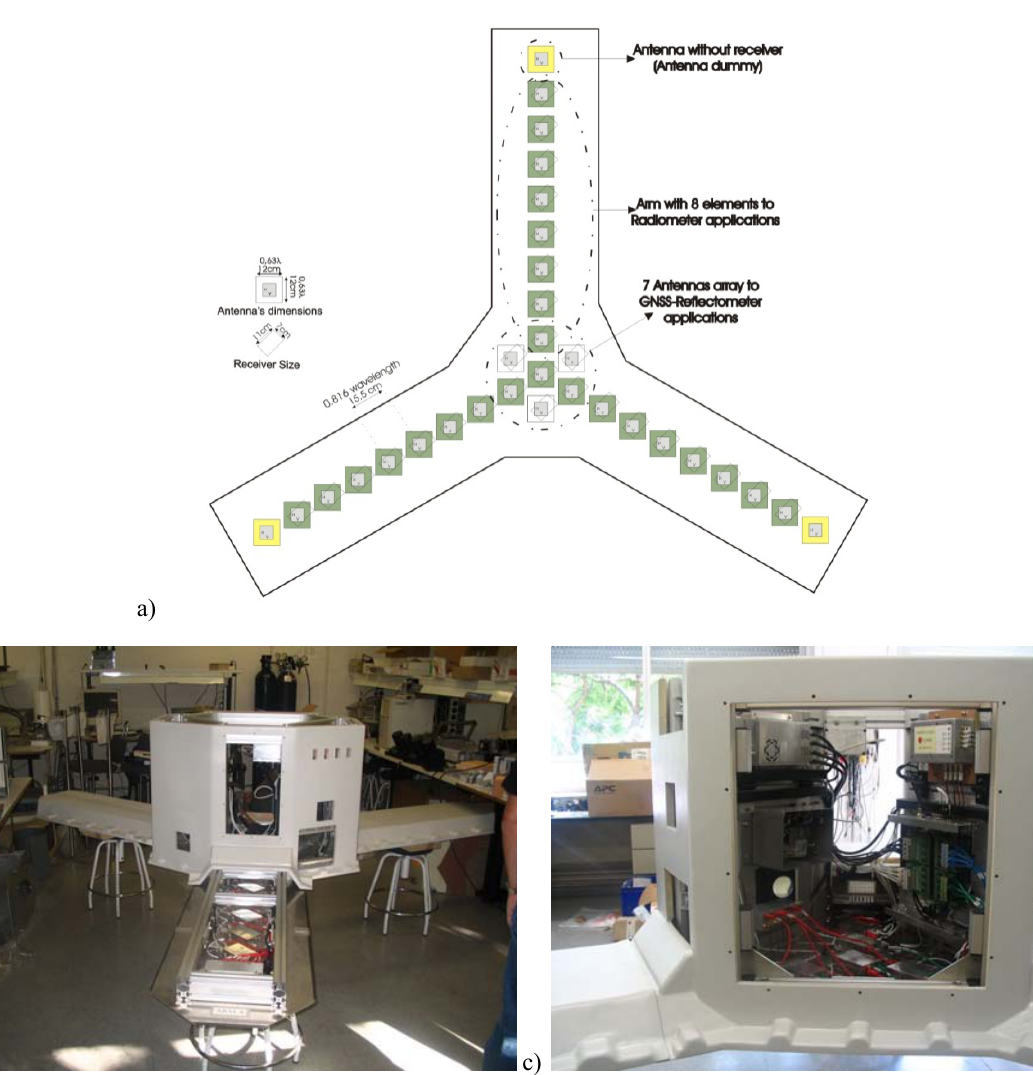
supply (left-hand side,